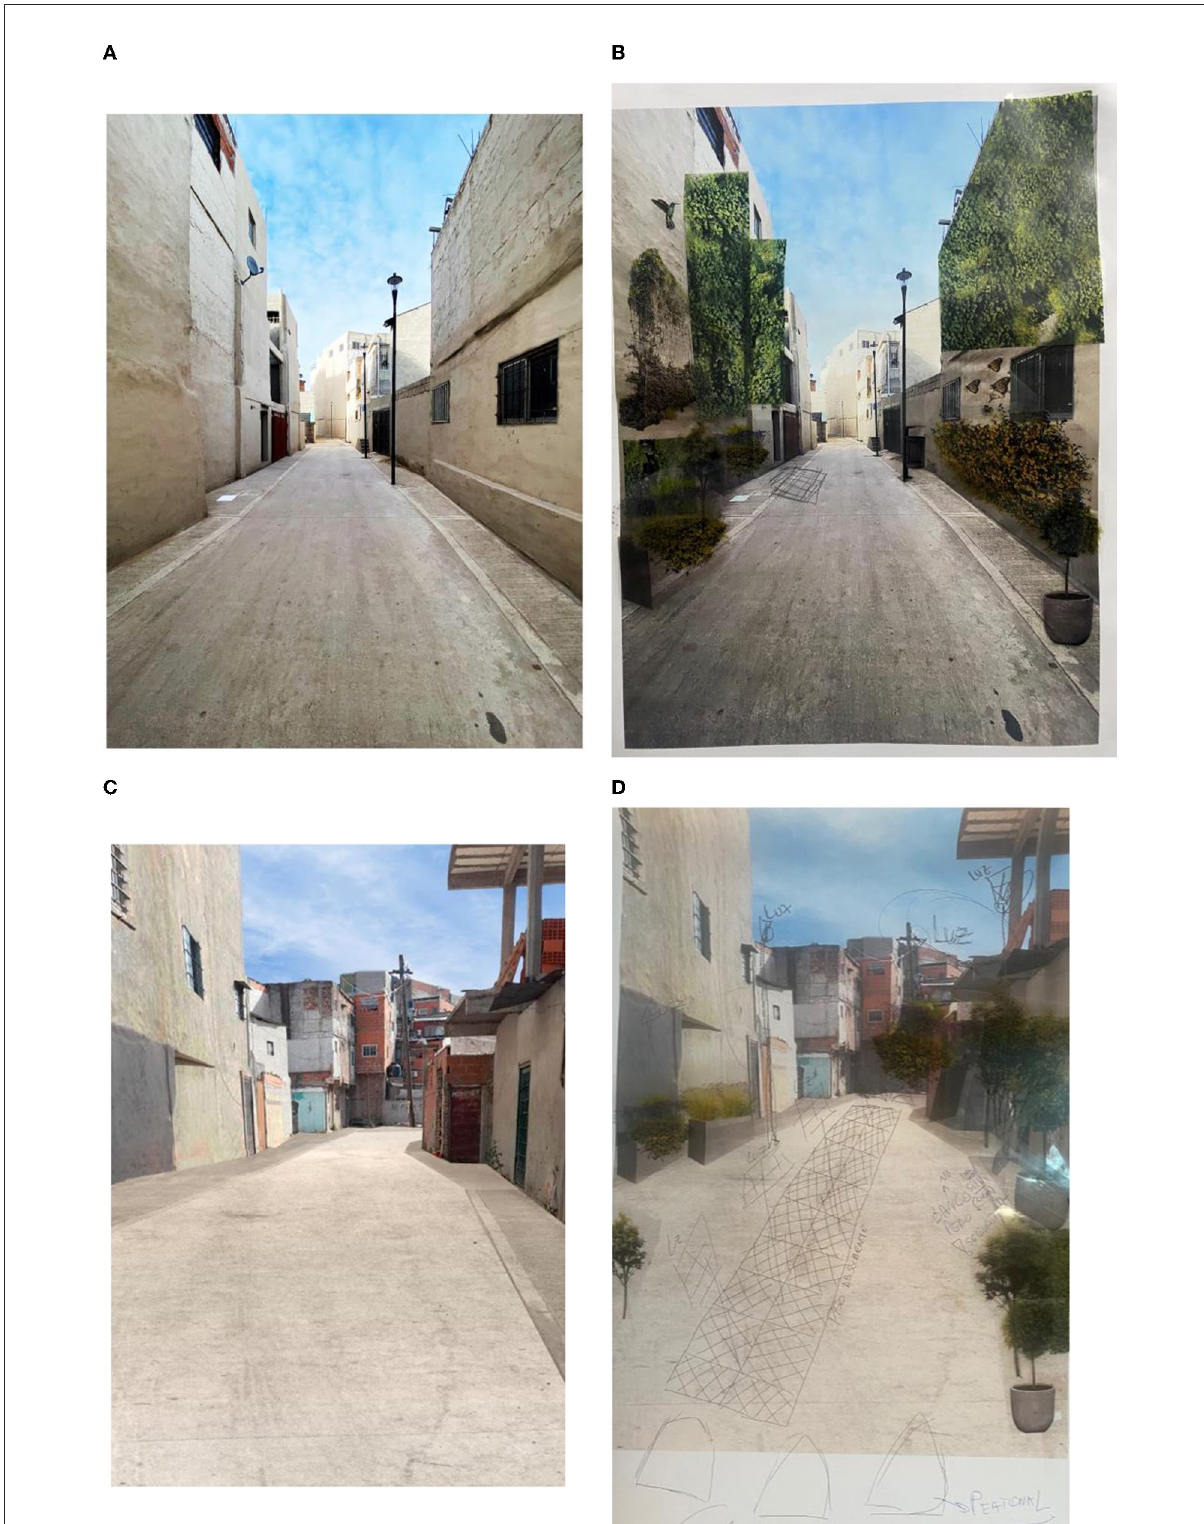
FIGURE9 (A–D) Working on ideas of pilot projects - Before and after - during Urban Lab meeting, June 2022. Source: Mariana Giusti for TUC program.